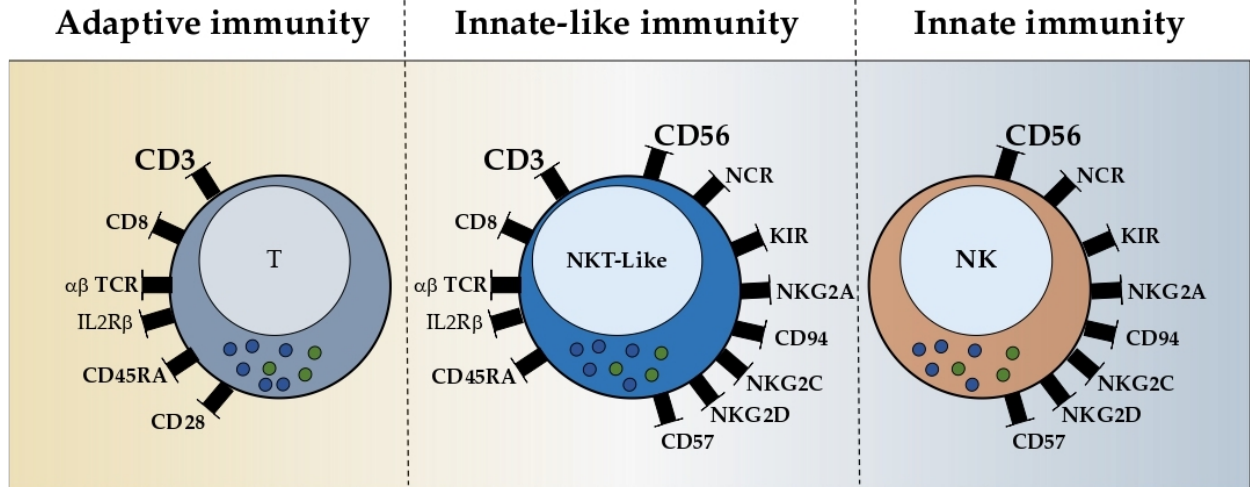
Figure 1. Receptor repertoire of NKT-like cells. NKT-like cells are T cells that acquire the expression of the CD56 molecule, as a typical marker of NK cells. In the middle of the image, it the receptor repertoire of NKT-like cells is presented, to the left, the receptor repertoire of T cells that are common to NKT-like cells is shown, and to the right, the receptor repertoire of NK cells that are common to NKT-like cells can be seen. T and NK cells are categorized as having an adaptive and innate immunity, respectively, whereas NKT-like cells are categorized with innate-like immunity, since NKT-like cells share mechanisms from both T and NK cells. The mature phenotype of NKT-like cells (CD45RA and CD57) includes a number of activating and inhibitory receptors (NCR, KIR, NKG2A/C/D, αβ TCR and IL2R β ). NKT-like cells also have a high capacity for cytokine production and cytotoxicity. Blue and green circles represent granules and cytokines, respectively. TCR — T cell receptor; NCR — natural cytotoxic receptor; KIR — killer-cell immunoglobulin-like receptor .